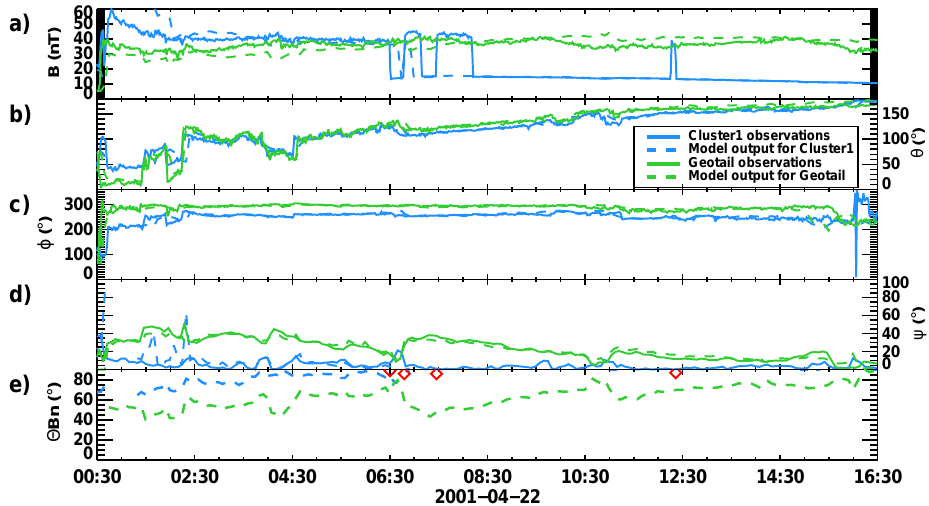
Figure 7. 22 April 2001 MC: comparison between the magnetosheath model’s results (dashed lines) and the observations (solid lines) at Cluster’s (blue lines) and Geotail’s (green lines) locations, in GSE coordinates. Same format as Fig.